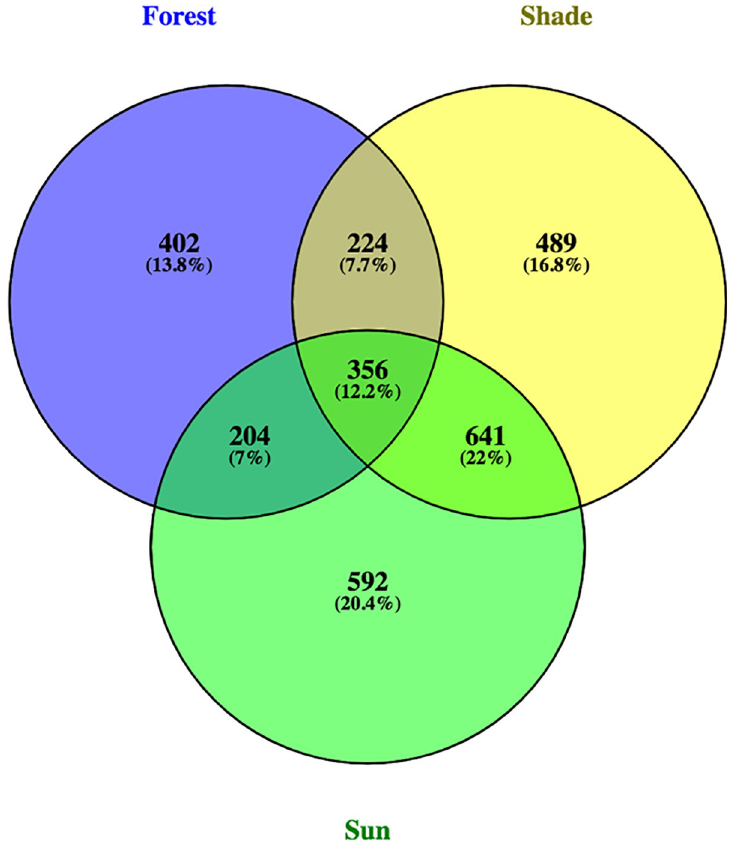
Fig 8. Venn diagram of shared and unique fungal ASVs among the three